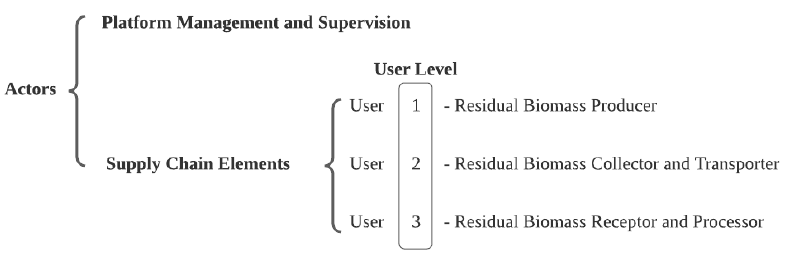
Figure 5. Operational framework of the residual biomass management platform to support the Bio- AgroFloRes project.